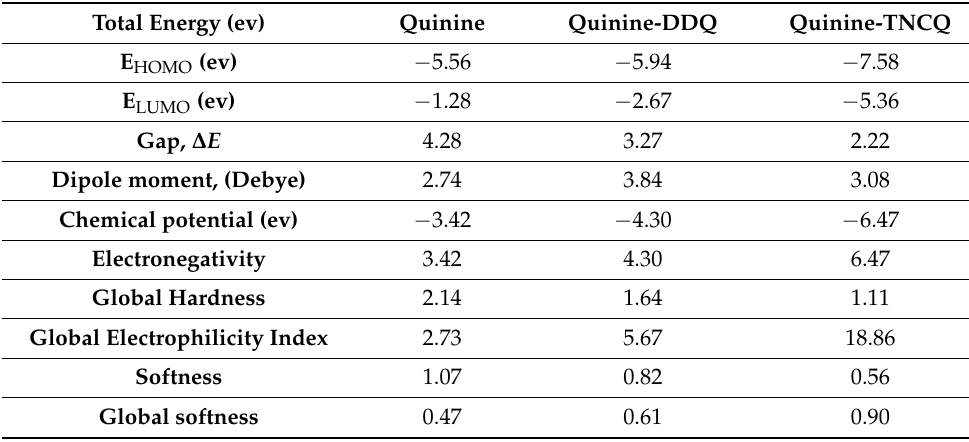
Figure 12. Molecular electrostatic potential maps of ( a ) TAM, ( b ) Quinine → DDQ, and ( c ) Quinine → TNCQ. Table 6. Calculated Energies of Quinine, Quinine-DDQ, and